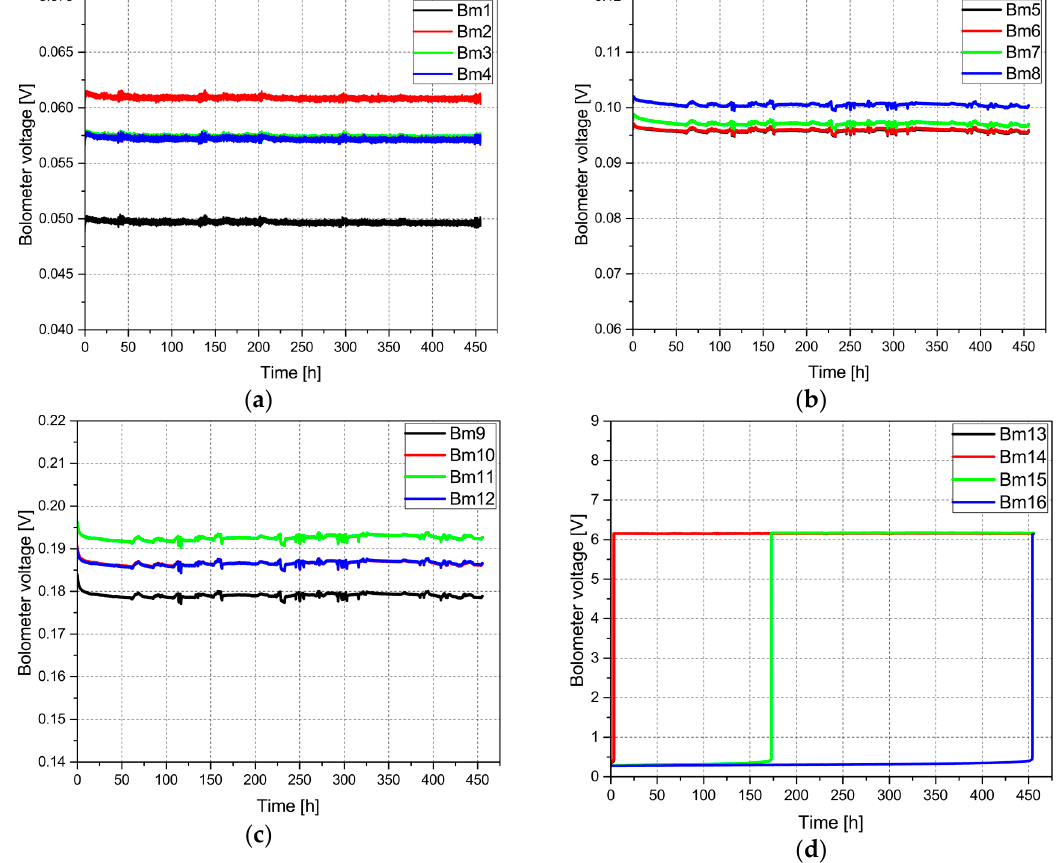
Figure 4. Lifetime measurement results for 16 micro-bolometers. Measured as four micro-bolometers together at: ( a ) 100 µA bias current; ( b ) 200 µA bias current; ( c ) 400 µA bias current and ( d ) 600 µA bias current.